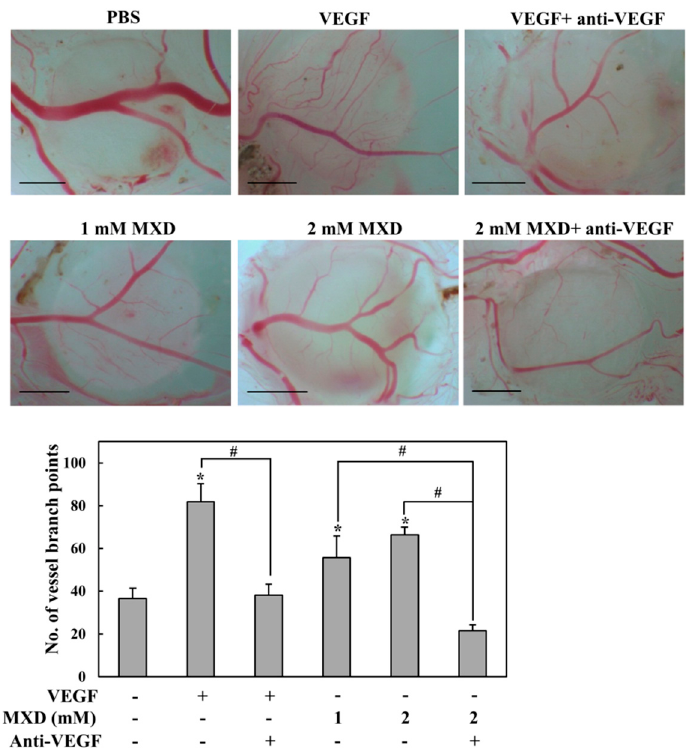
Figure 6. Millimolar minoxidil promotes angiogenesis. A chorioallantoic membrane (CAM) assay was performed in the presence of minoxidil (MXD), VEGF (20 ng/mL), VEGF (20 ng/mL)/VEGF-neutralizing antibody (anti-VEGF, 20 ng/mL), or MXD/anti-VEGF (20 ng/mL) and phosphate buffered saline (PBS) was used as a negative control. The number of vessel branch points was counted by two observers in a double-blind manner. Upper panel: Representative images of angiogenesis. The scale bar at the bottom left of each image represents 2 mm. Lower panel: Vessel branch points were quantified. The data represent the mean ± SEM ( n = 5) * p < 0.05 versus untreated group, # p < 0.05 .